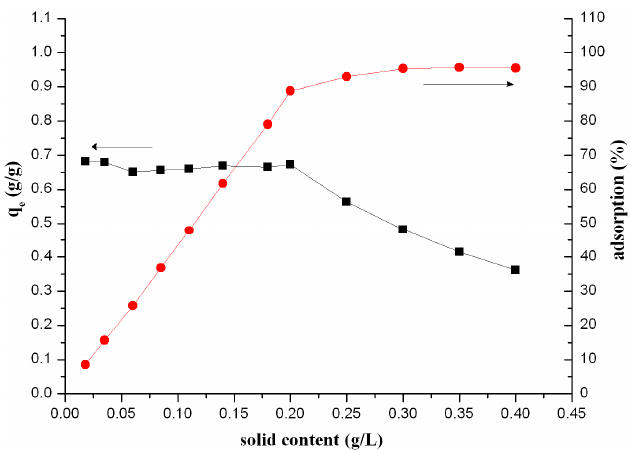
Figure 8. Effect of solid content on the adsorption of Th(IV) onto β -CD(AN- co -AA), square point show the value of q e (g/g) and dot show the value of “adsorption %” ([Th(VI)] 0 = 6.5334 × 10 − 4 M, pH = 2.95 ± 0.05, T = 298.15 ± 1.00 K, I = 0.50 M NaNO 3